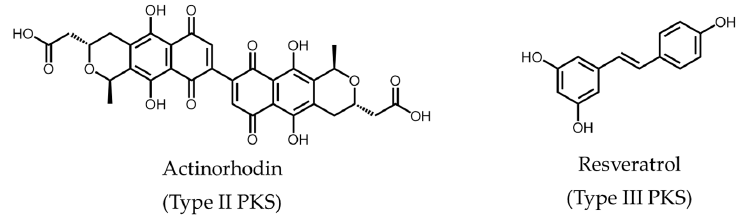
Figure 1. Examples of polyketides synthesized by the different classes of PKSs.